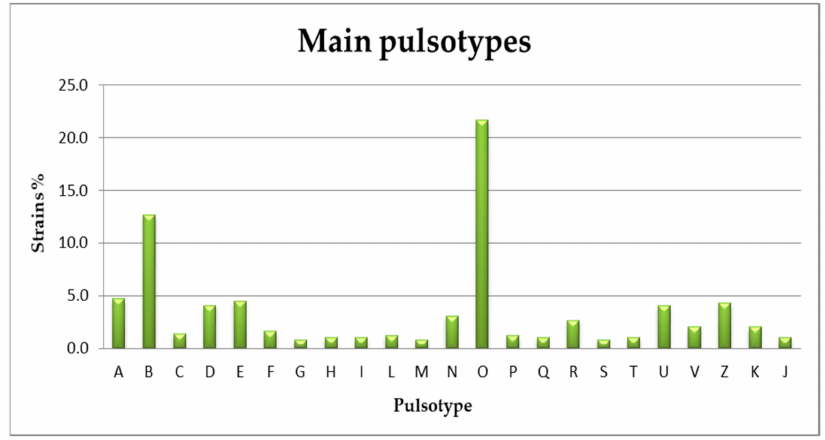
Figure 2. Main pulsotypes detected in 490 Listeria monocytogenes strains analyzed during the outbreak